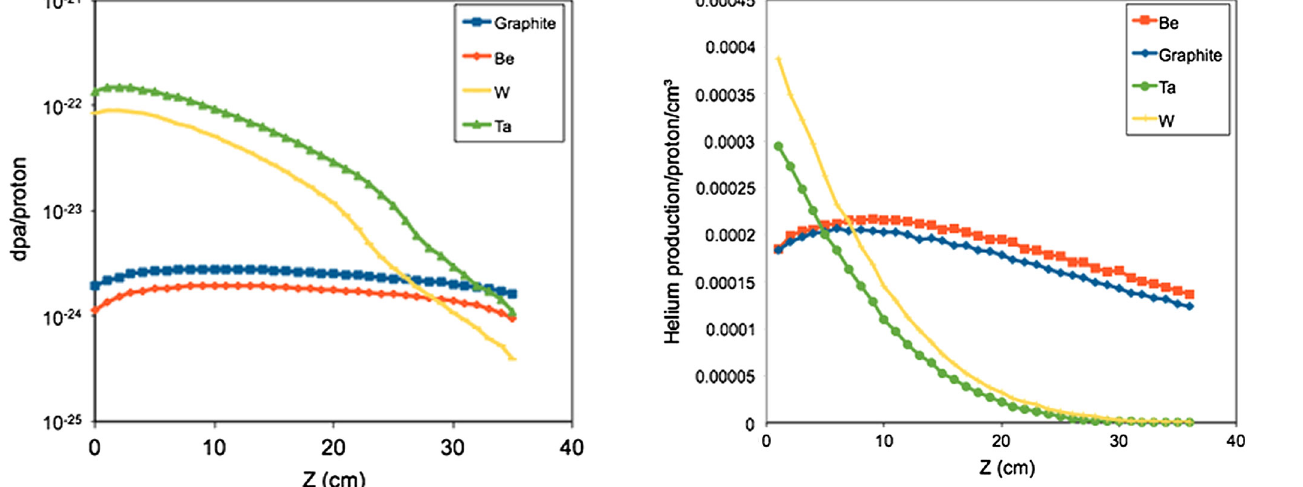
materials.FIG. 5 (color online). DPA variations with target depth for different target